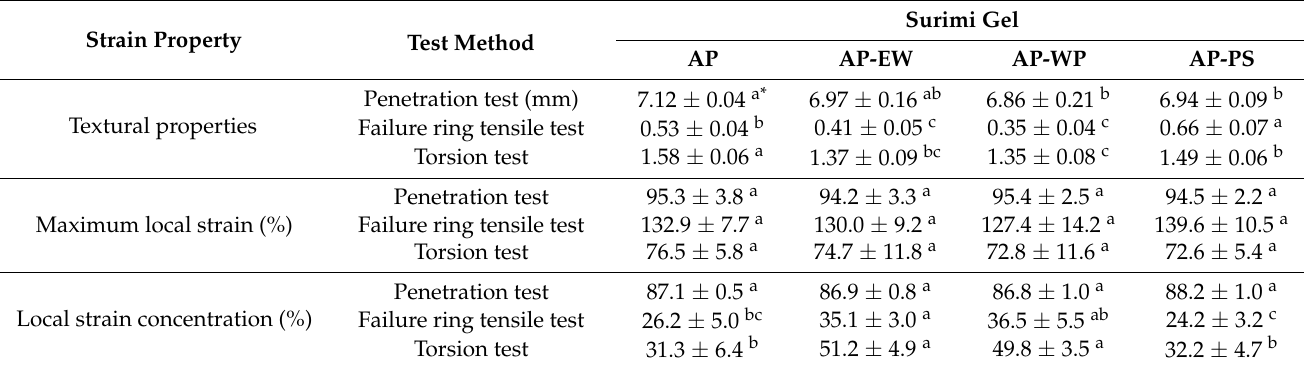
Table 1. Strain properties of the surimi gels.